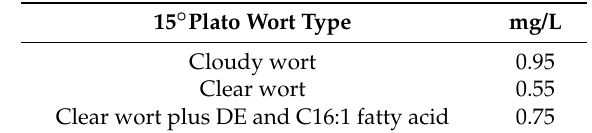
Table 8. Isoamyl acetate concentration (mg/L) following 160 h fermentation of different 15 ◦ Plato wort types [32].